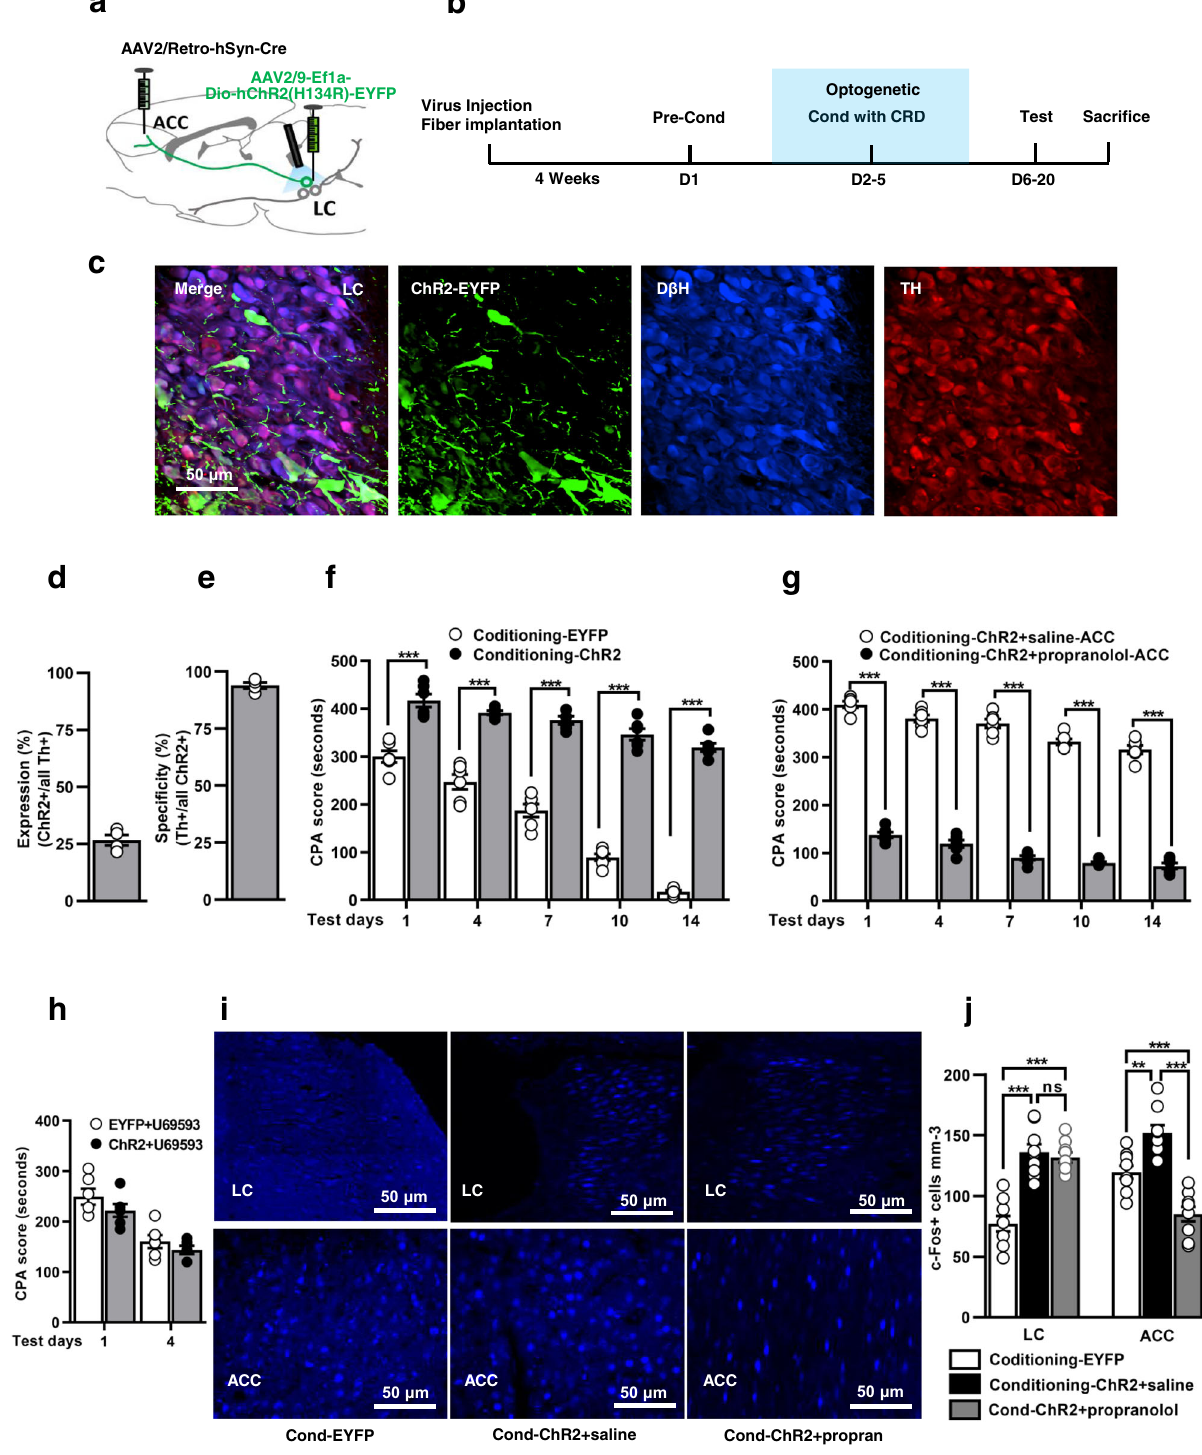
activation did not affect the CRD-induced VMR (Supplementary Fig. 2g, h and Supplementary Data 1). We report Gi pathway activation impairs the aversive memory formation due to disruption in memory-related plasticity changes.